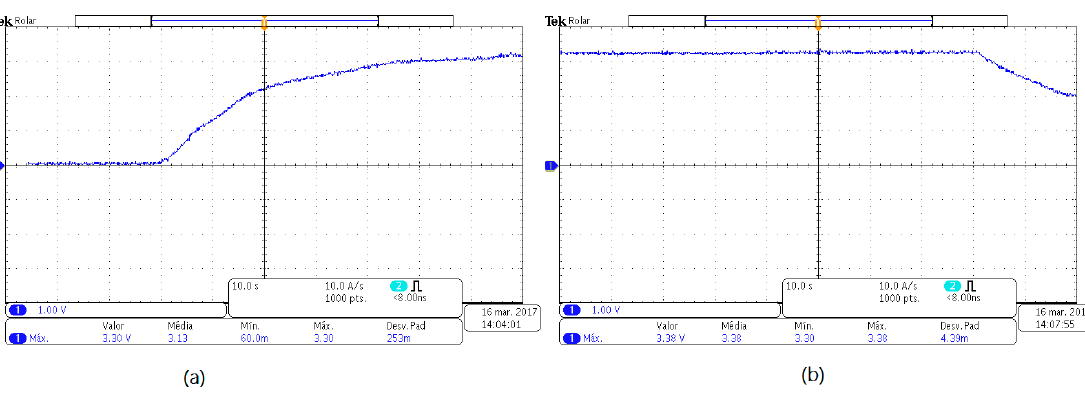
Figure 15. ( a ) Stabilized voltage; ( b ) Voltage after stopping transmitting.